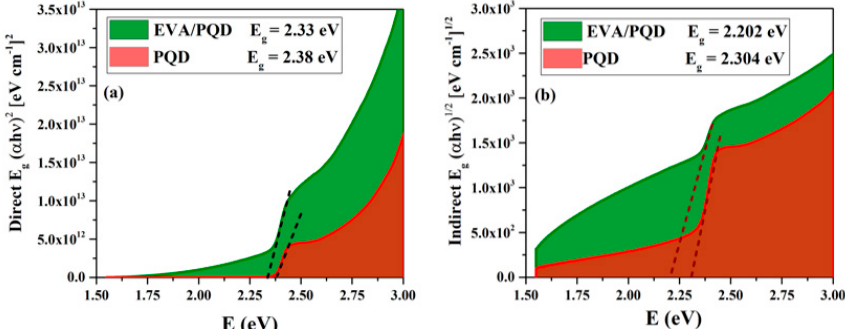
Figure 5. ( a ) Direct and ( b ) indirect band gaps of the pure PQD and the EVA-TPR/PQD films. The profiles of the absorption coefficients of both films are shown as a function of wavelength in Figure 6 and were calculated using (α = 2.303 xA ) [38–40], where A is the absorbance and l is the thickness of the film. The features of α ( λ ) are closely related to the absorbance spectra. At longer wavelengths (510 nm), α ( λ ) is very low for the pure film and increases linearly for the composite film. Then, α ( λ ) surges sharply from 0.21 to 1 for the pure film and less sharply from 0.76 to 1.2 for the composite film at 508 ± 2 nm. This indicates that the optical properties of the PQD composite were improved. The high absorption coefficient values and inherently protective passivation by EVA clearly demonstrate that EVA is capable of being an active layer in solar cell optoelectronic devices. The high α ( λ ) is evidence of high excitonic creation in the excited states, and the excitons have the potential for high conversion to charge carriers, which is crucial for the effective light harvesting of the materials [35,41,42].